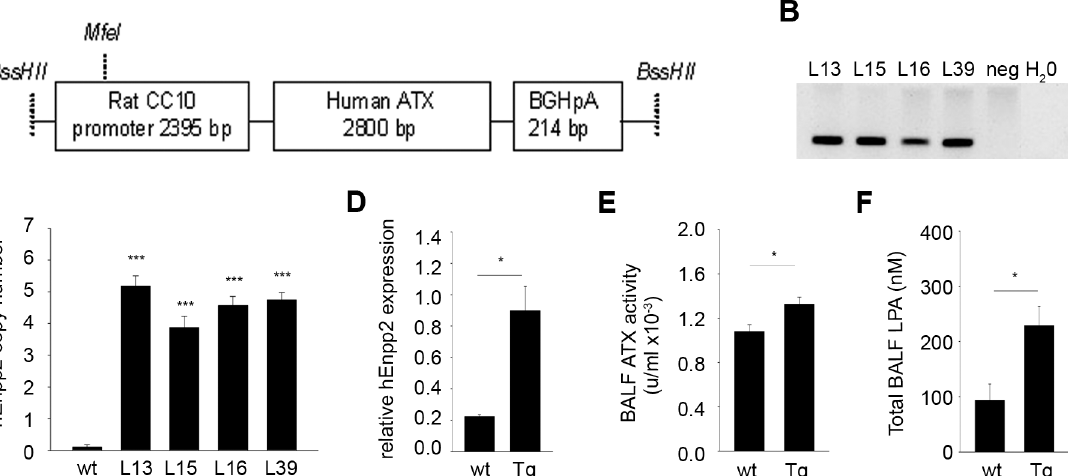
Fig 3. Generation of Tg CC10Enpp2 mice. A. Schematic representation of the construct used for the generation of the transgenic mice. B. Genotyping PCR of the 4 offsprings that carried the transgene, out of the 54 that were generated after the injections of the trangene-microinjected zygotes in surrogate mothers. C. All four transgenic lines contained equal copy numbers, as identified with Real-Time PCR. D. Real-Time RT-PCR confirmed the expression of the transgene (L39 is shown). E. Total ATX activity levels in the BALFs of Tg CC10Enpp2 mice (L39) were found moderately upregulated with the TOOS assay. F. In the same mice, BALF LPA was also found elevated, as measured with HPLC-MS/MS. (C-F n = 3 – 8).